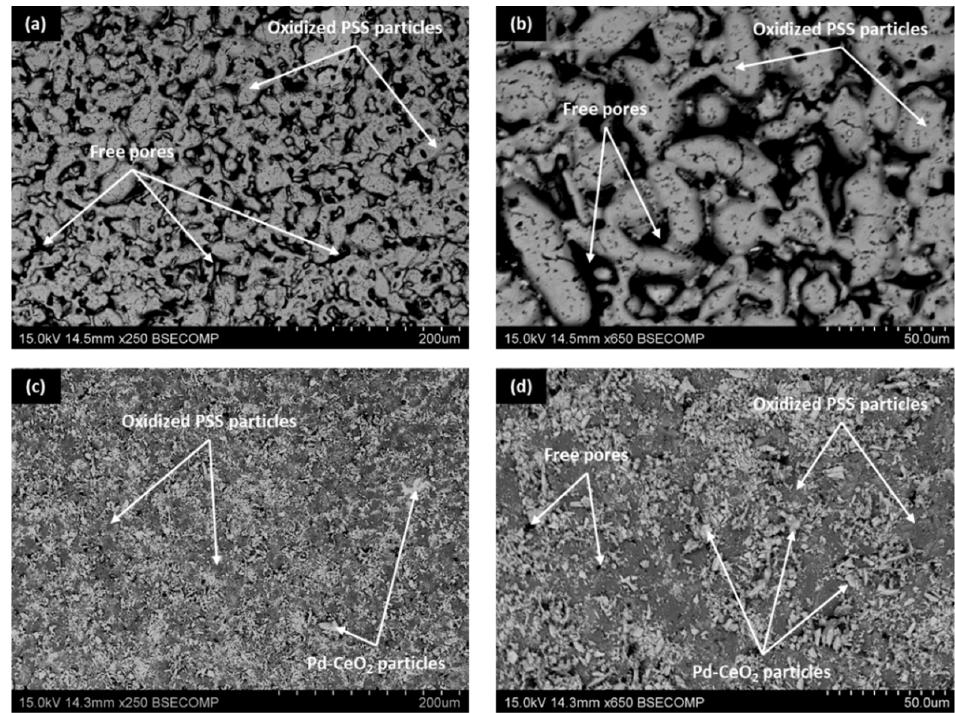
Figure 3. SEM images of PSS tubes after the incorporation of internal intermediate layers at diverse magnification: Fe–Cr oxides by calcination in air ( a , b ) and Pd–CeO 2 particles by PA ‐ DC ( c , d ).